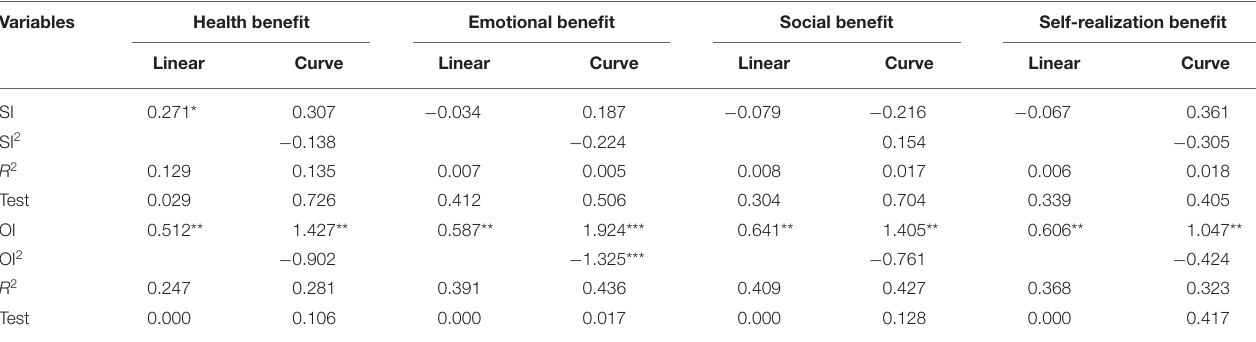
TABLE 2 | The effects of the degree of leisure involvement on physiological pragmatic leisure benefits in older adults. Variables